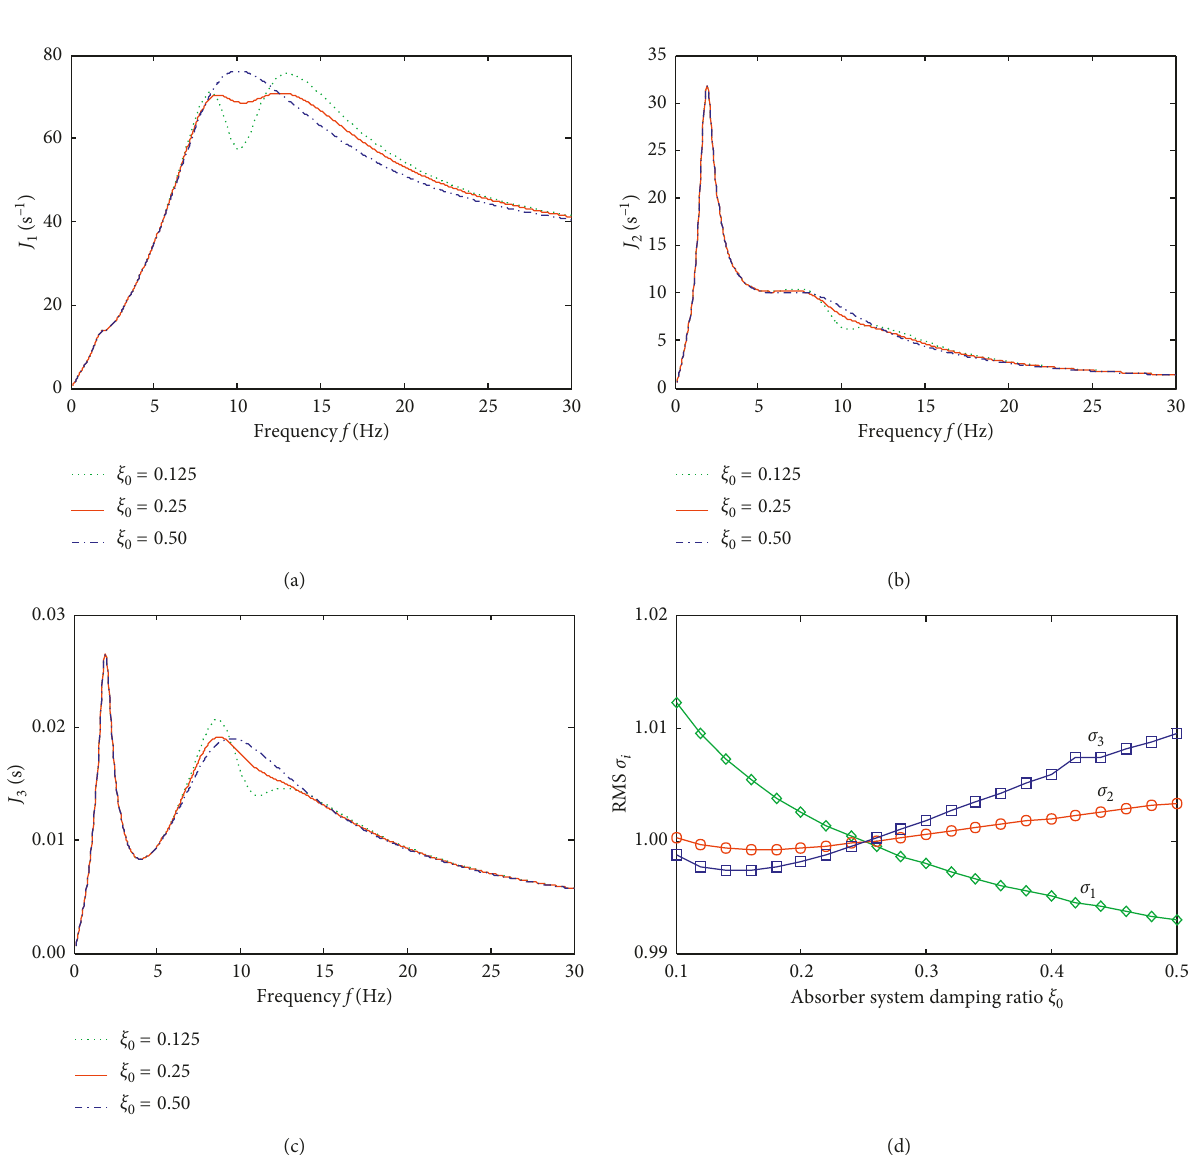
at different values of ξ 1 at different values of ξ 3